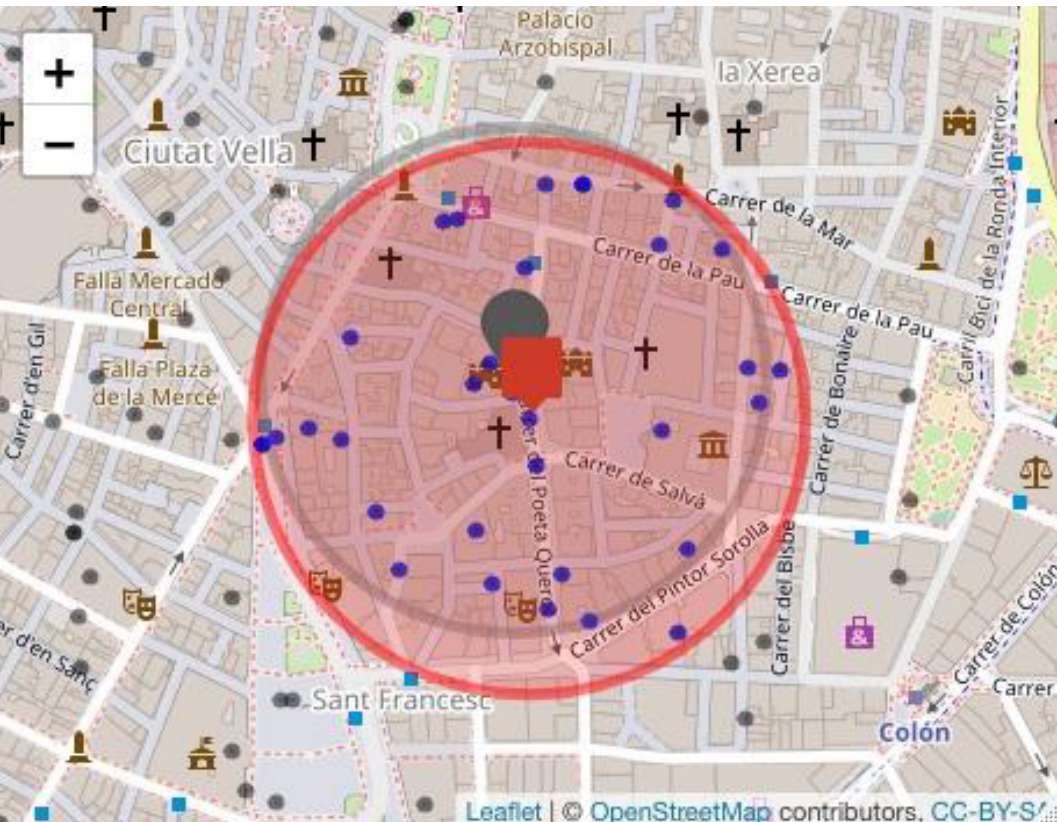
Figure 5. The highest risk cluster for the insurance company considering a radius of 220 m (radius = 200 m, margin = 20 m). Haversine distance is used. Interactive map available at: https://go.uv.es/vcoll/cumulus_4 (accessed on 31 May 2021).